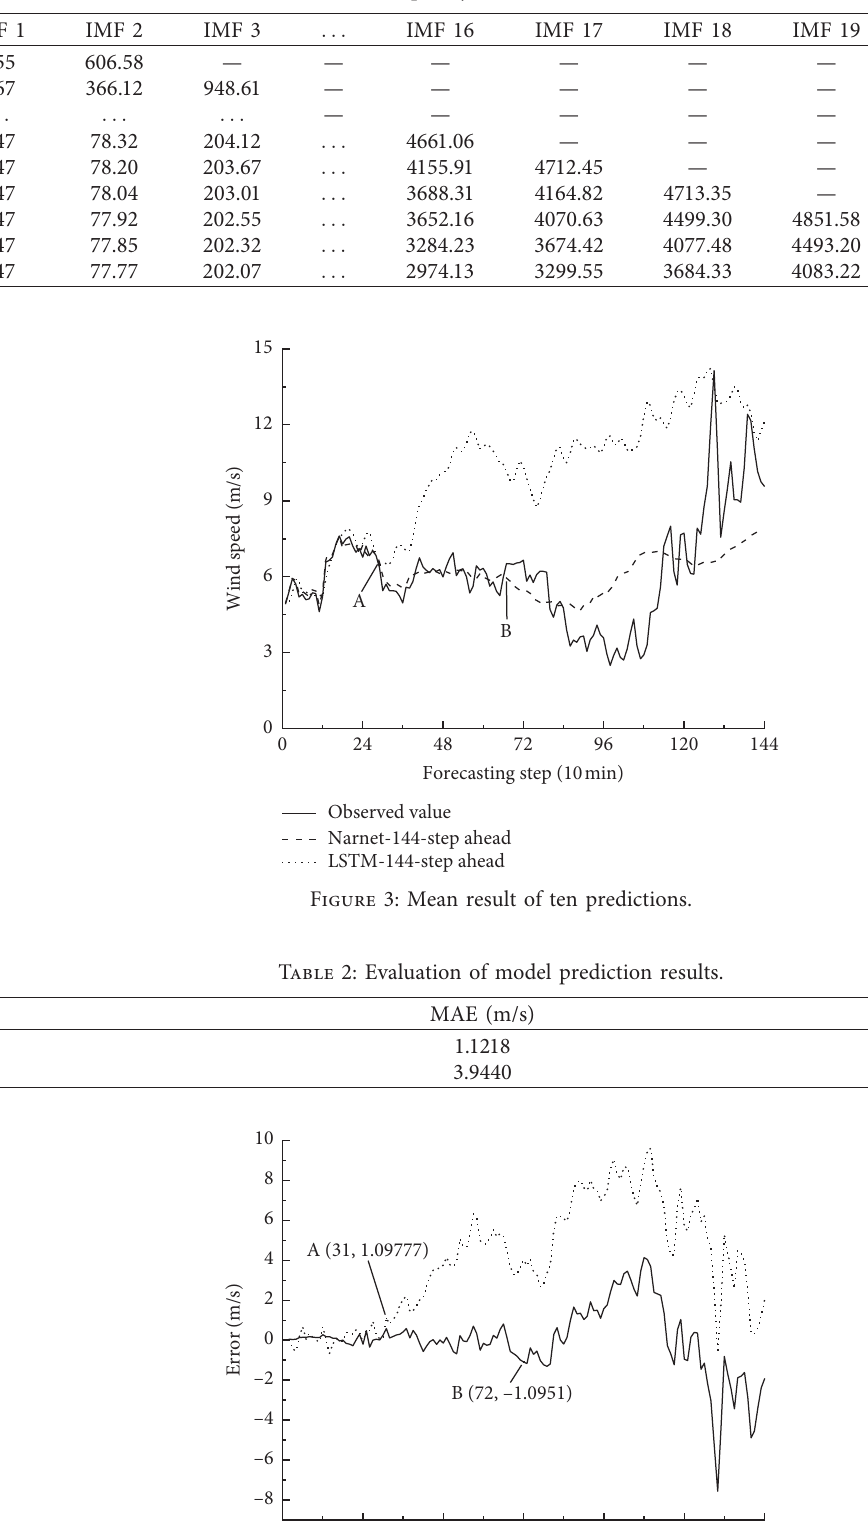
Table 1: Central frequency ( ω k ) of IMF at different k values.